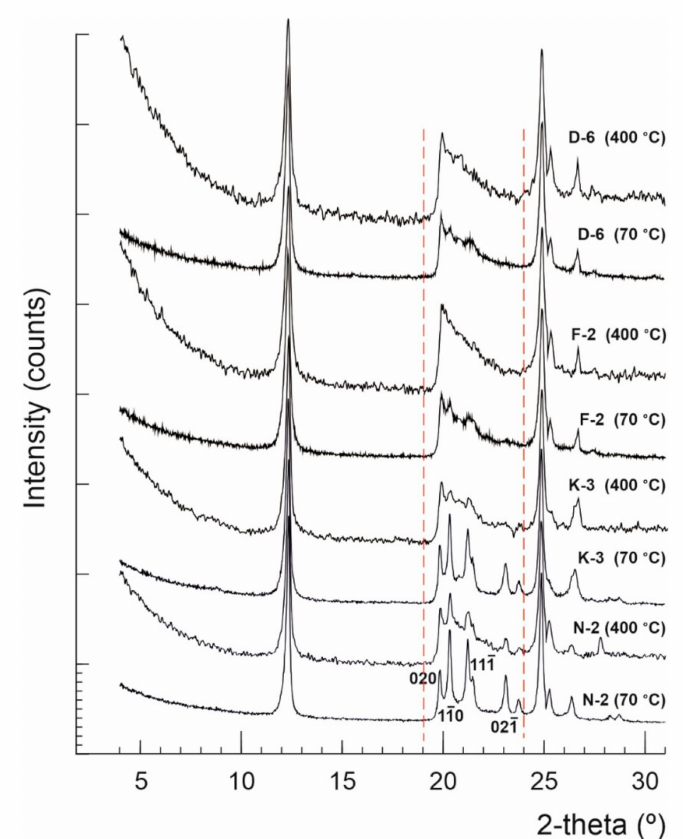
Figure 2. X-ray di ff ractograms showing kaolinite structural changes between the precursor (dried at 70 ◦ C) and the dehydrated (heated up to 400 ◦ C) kaolin